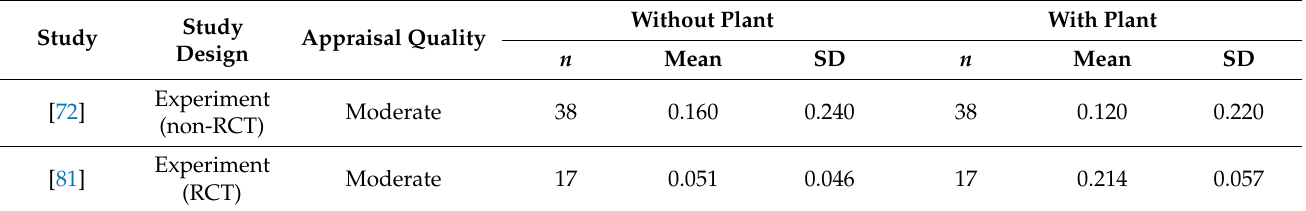
Table 12. Original data of the studies examining the influence of indoor plants on EEG β waves.